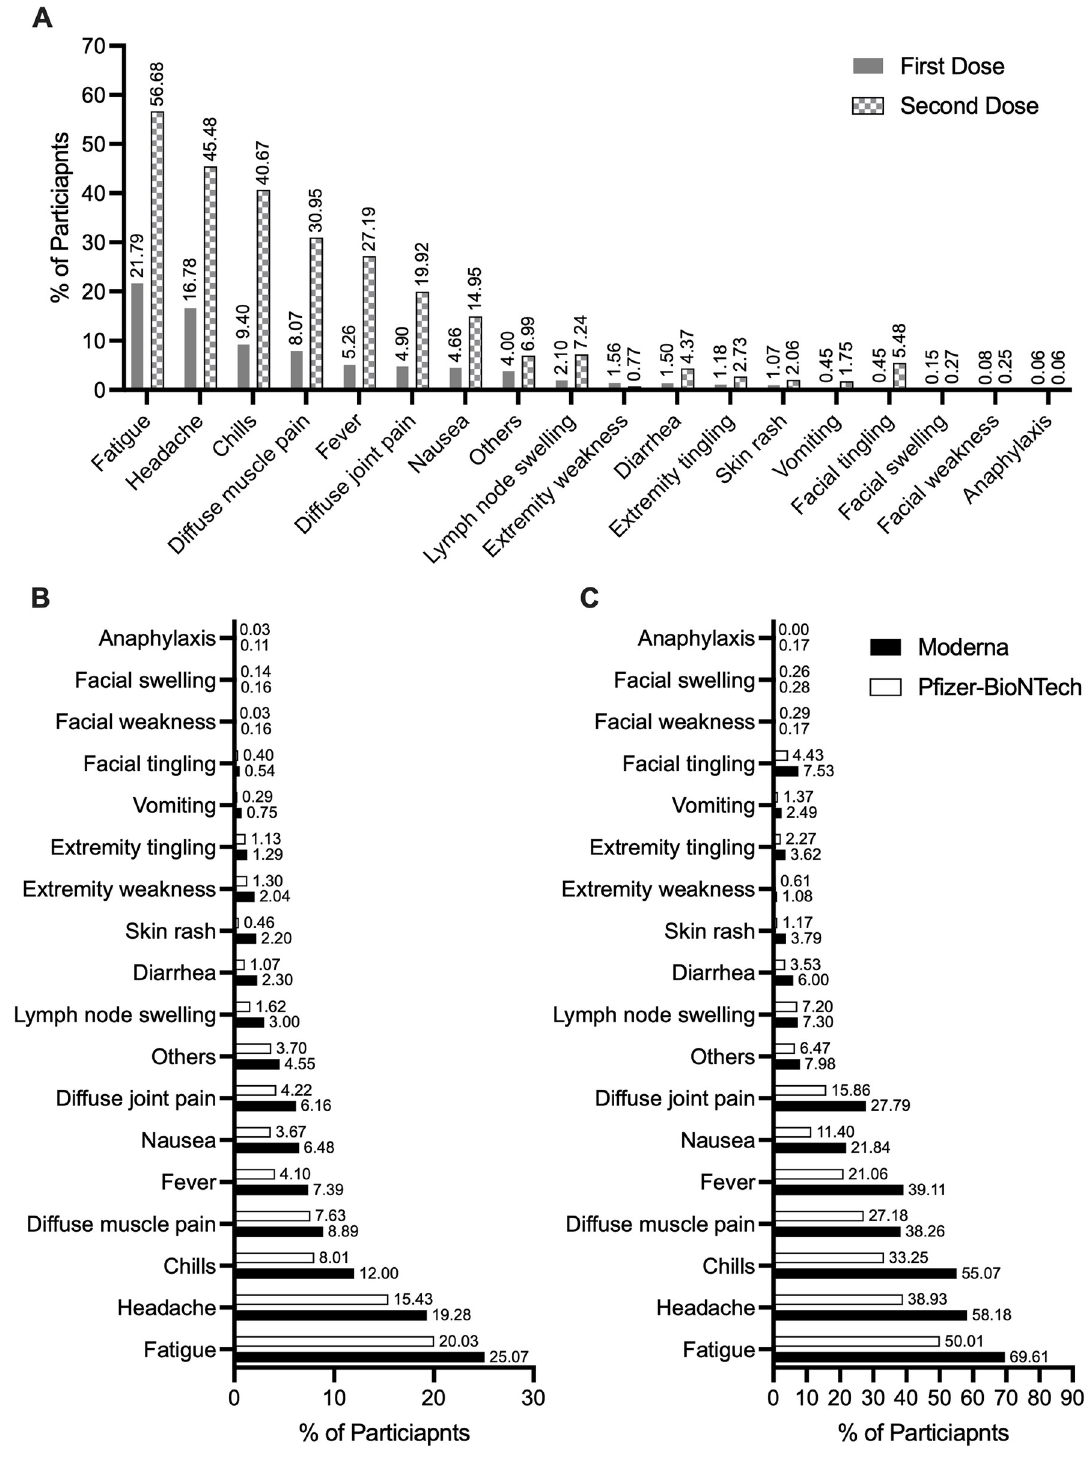
Fig 2. Frequency of systemic reactions after the first and second vaccine dose. (A) Frequency of systemic reactions after the first and second vaccine dose across the full study population (B) Frequency of systemic reactions following the first vaccine dose by vaccine brand. (C) Frequency of systemic reactions following the second vaccine dose by vaccine brand.